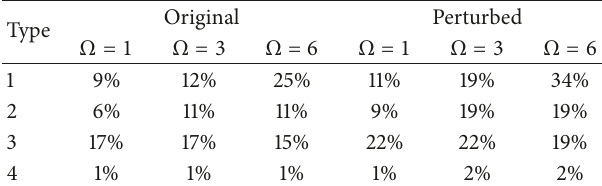
Table 9: Rate for 4 types of emergence.